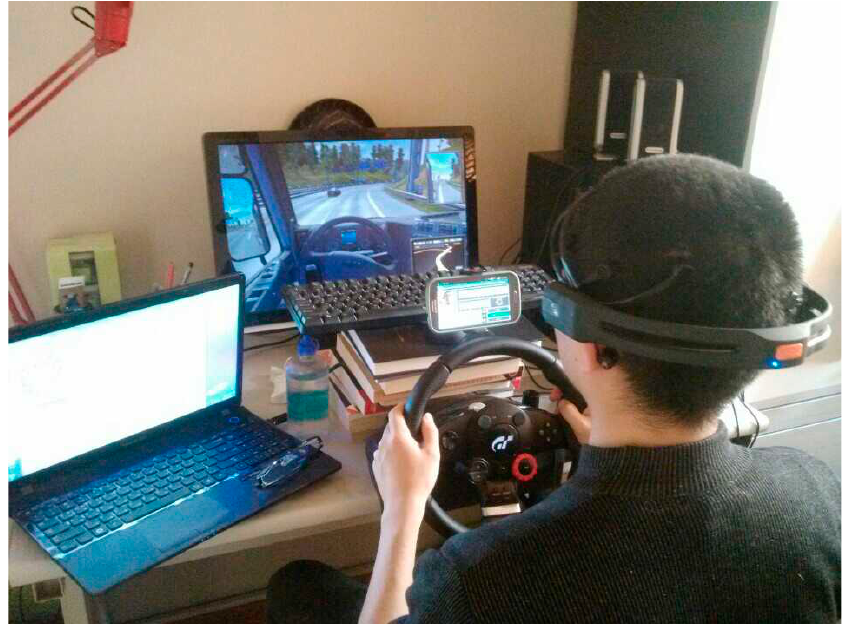
Figure 8. Example of the experimental setup for monotonous